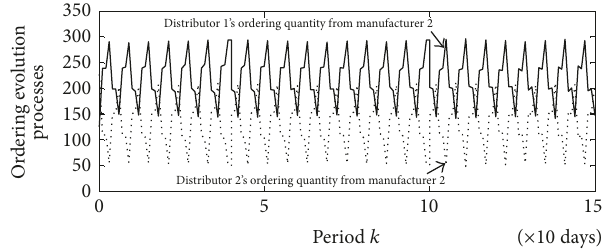
Figure 10: Production evolution processes under the fuzzy robust strategy ( ×10 4 ton).